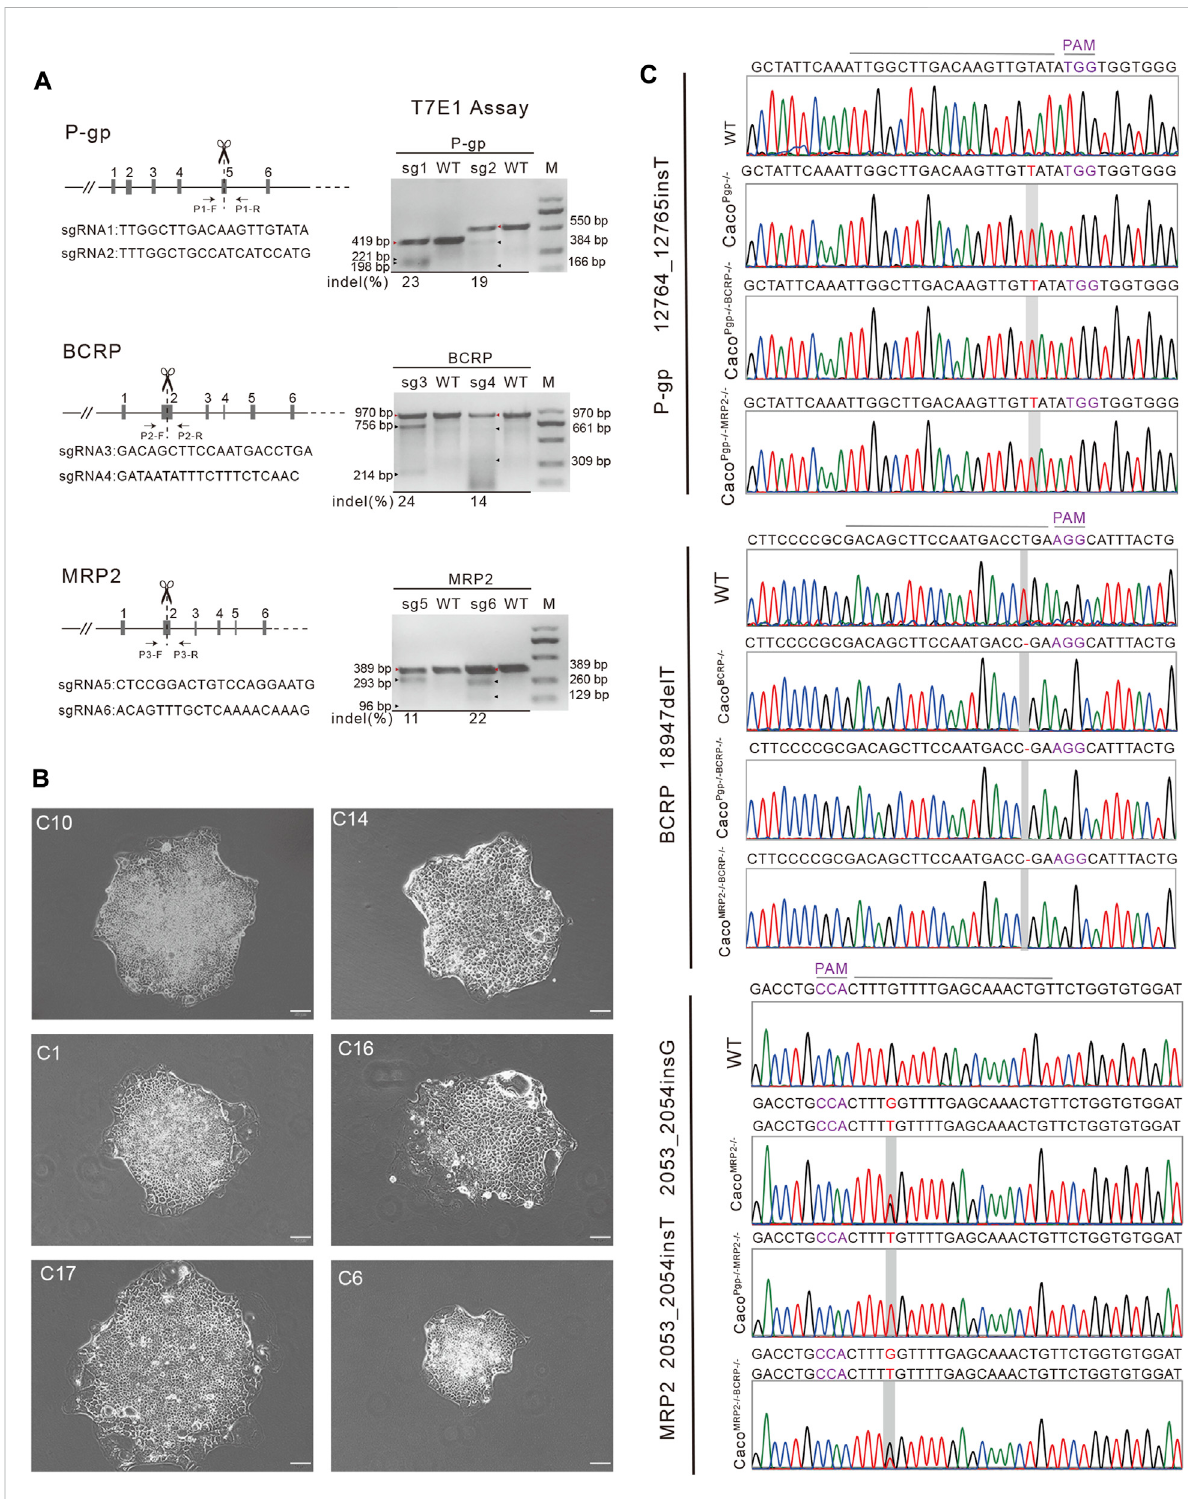
FIGURE 1 Establishment of single and double transporter KO cell lines clones. (A) Target sgRNA design for P-gp, BCRP and MRP2 and T7E1 assay. M: DNA marker. The red triangles are the parental bands and the black triangles are cleavage bands. (B) A portion of the harvested single colonies. Scale bar, 50 μ m. (C) Sequencing results of the targeted allele in P-gp, BCRP and MRP2 knockout Caco-2 cell lines. PAM: protospacer adjacent